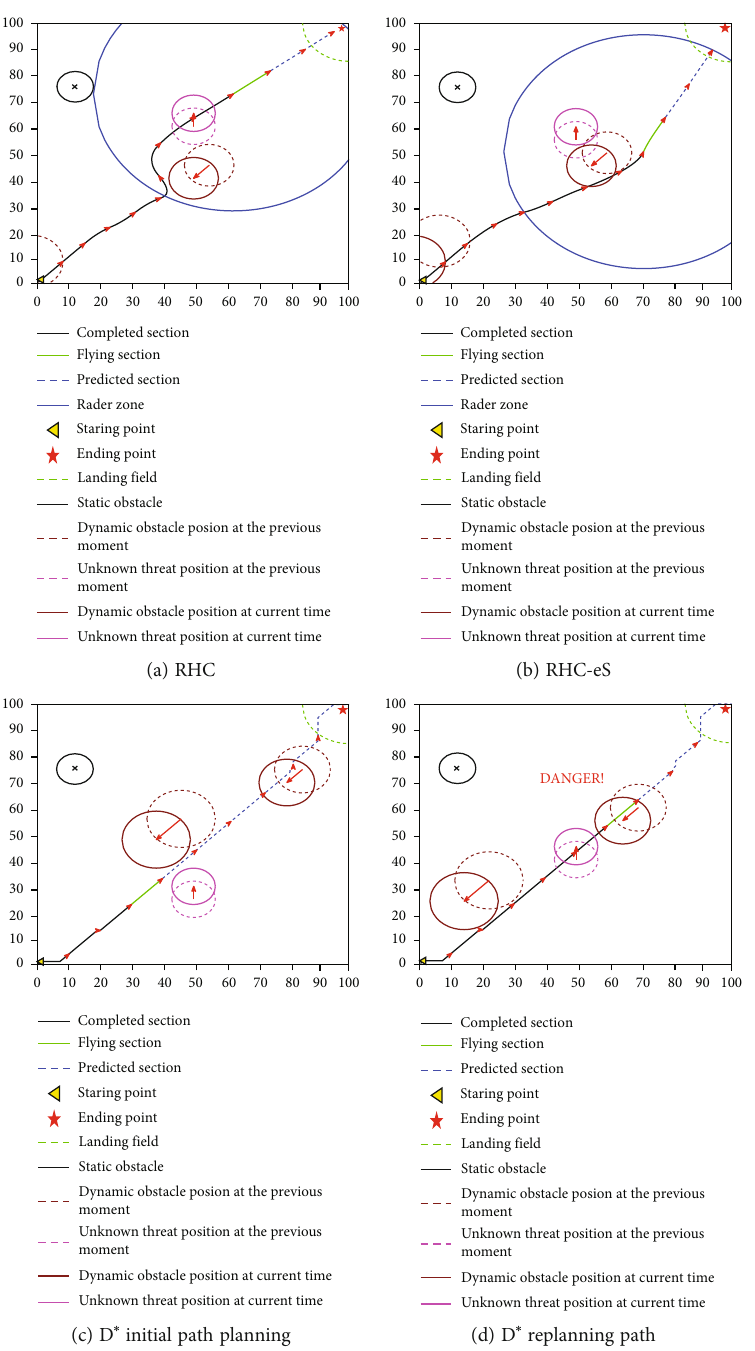
Figure 9: Environmental case 5 path planning